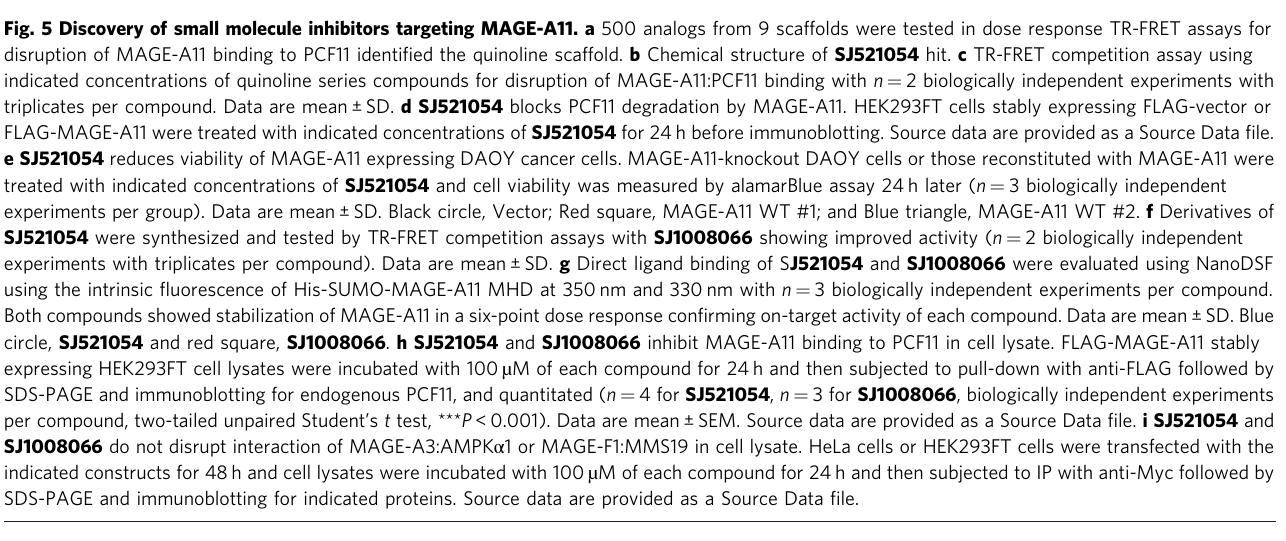
Fig. 5 Discovery of small molecule inhibitors targeting MAGE-A11. a 500 analogs from 9 scaffolds were tested in dose response TR-FRET assays for disruption of MAGE-A11 binding to PCF11 identi fi ed the quinoline scaffold. b Chemical structure of SJ521054 hit. c TR-FRET competition assay using indicated concentrations of quinoline series compounds for disruption of MAGE-A11:PCF11 binding with n = 2 biologically independent experiments with triplicates per compound. Data are mean ± SD. d SJ521054 blocks PCF11 degradation by MAGE-A11. HEK293FT cells stably expressing FLAG-vector or FLAG-MAGE-A11 were treated with indicated concentrations of SJ521054 for 24 h before immunoblotting. Source data are provided as a Source Data fi le. e SJ521054 reduces viability of MAGE-A11 expressing DAOY cancer cells. MAGE-A11-knockout DAOY cells or those reconstituted with MAGE-A11